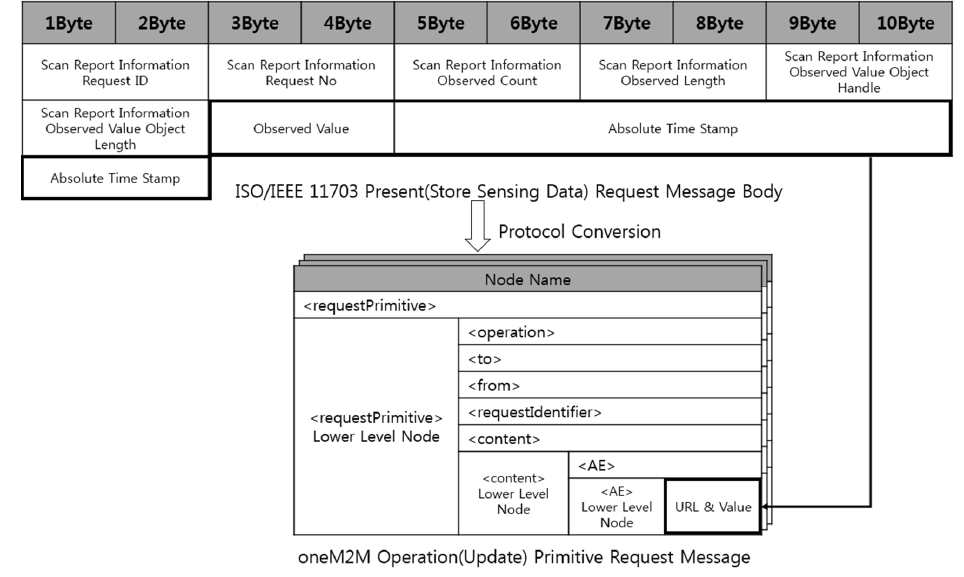
Figure 11. Conversion of an ISO/IEEE 11073 Present (Store Sensing Data) Request message to oneM2M Update primitive Request messages.